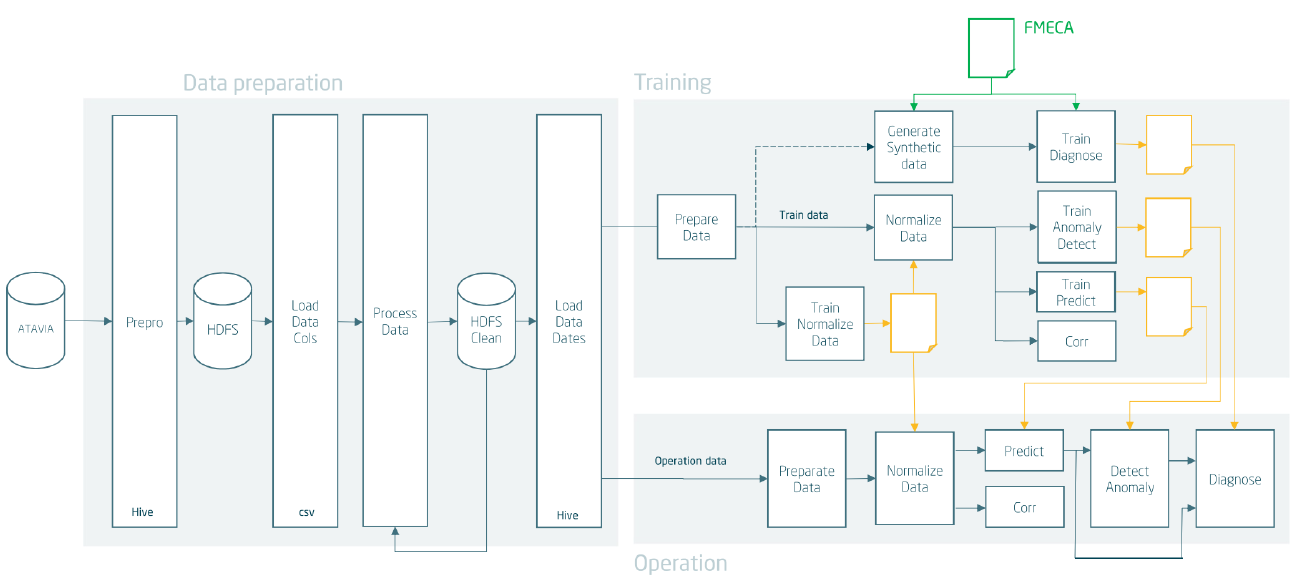
Figure 1. Architectural design. SOPRENE is composed by three big subsystems: processing, training and operation. Processing subsystem is common to training and